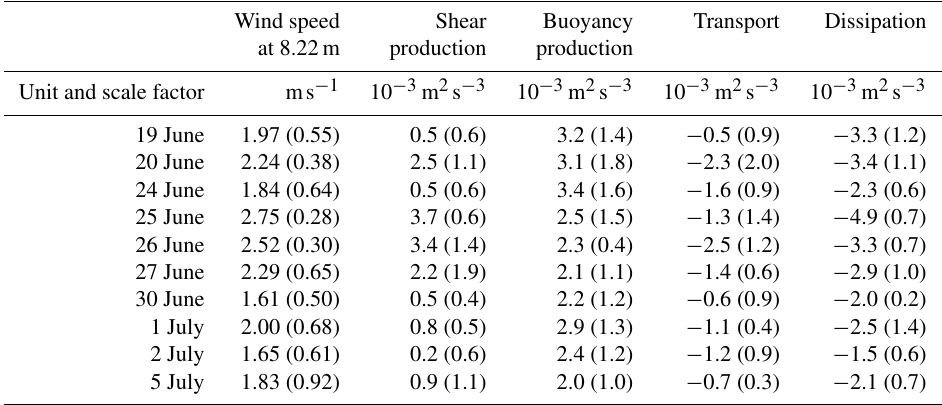
Table B2. Afternoon statistics of wind speed, shear production, buoyancy production, transport and dissipation for a measurement height of 8.22m. Here, the mean value (and standard deviation) for each afternoon period was calculated from the hourly TKE budget results presented in Fig. 5. Note the scale factor of 10 − 3 for the TKE budget